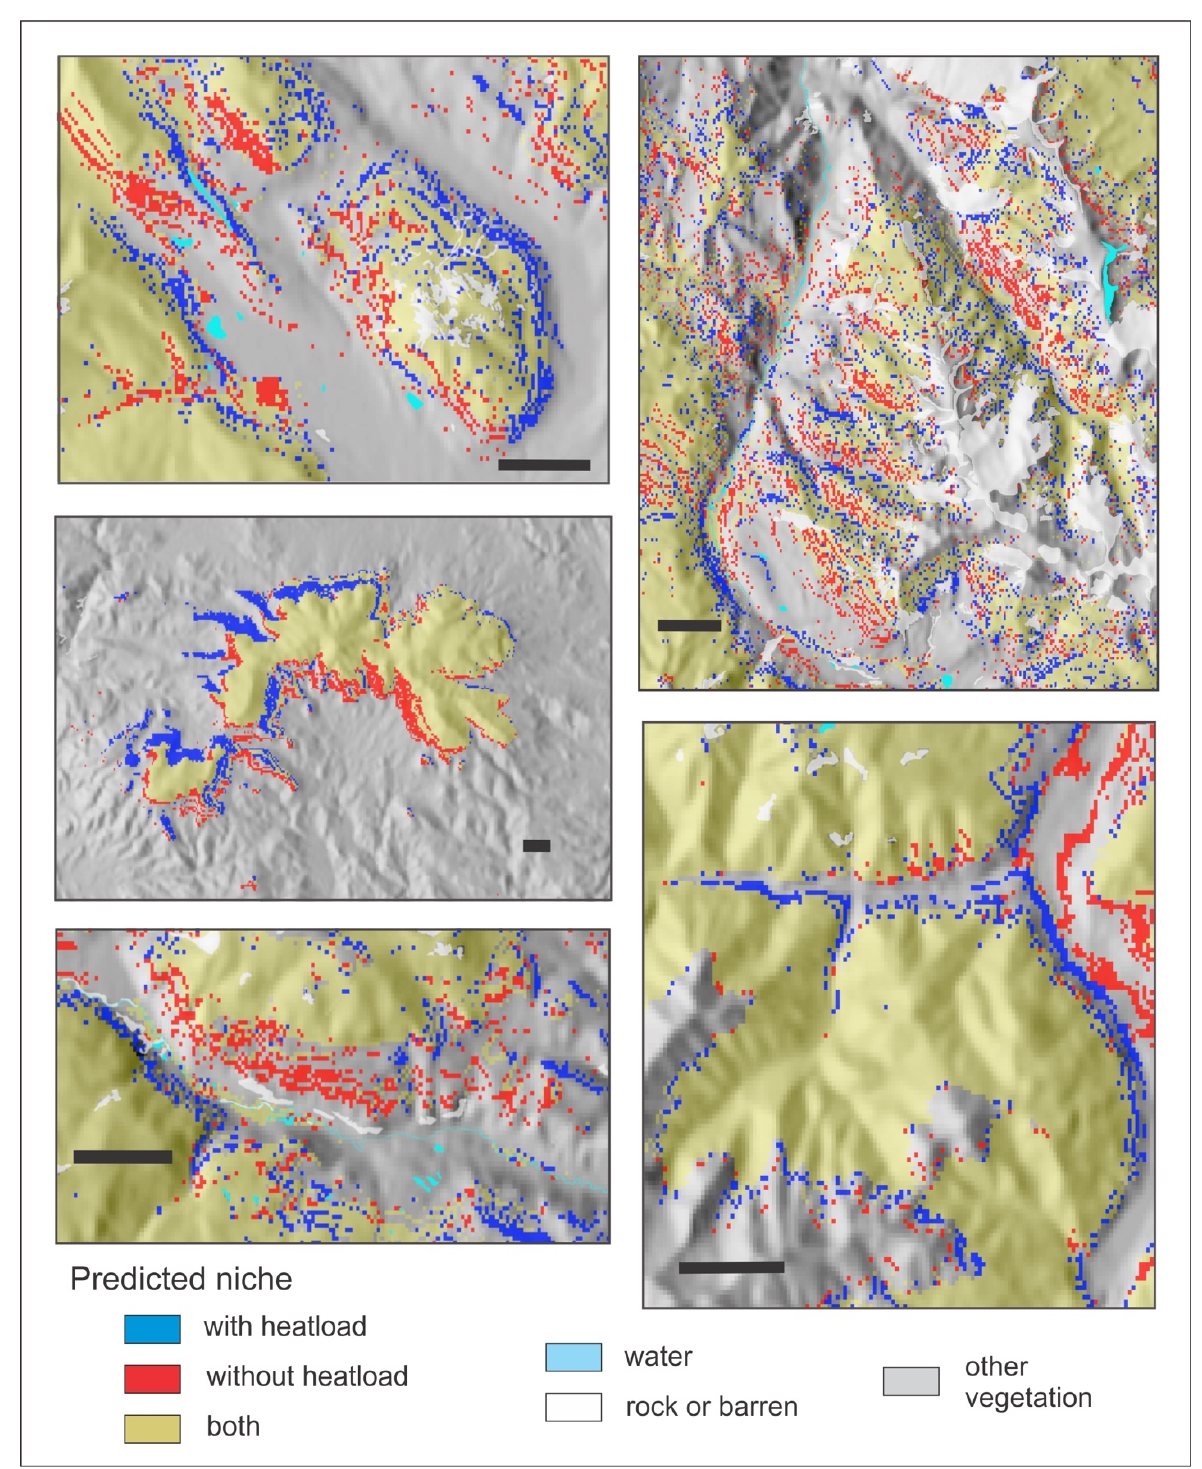
Figure A4. Reference period predicted niche of Picea engelmannii from two random forests classification trees illustrating the effects of heatload as a predictor. Gold, niche predicted by both models; red, predicted by 11 climate variables; blue, predicted by the climate variables plus heatload. Scale bar in each panel is 2 km.